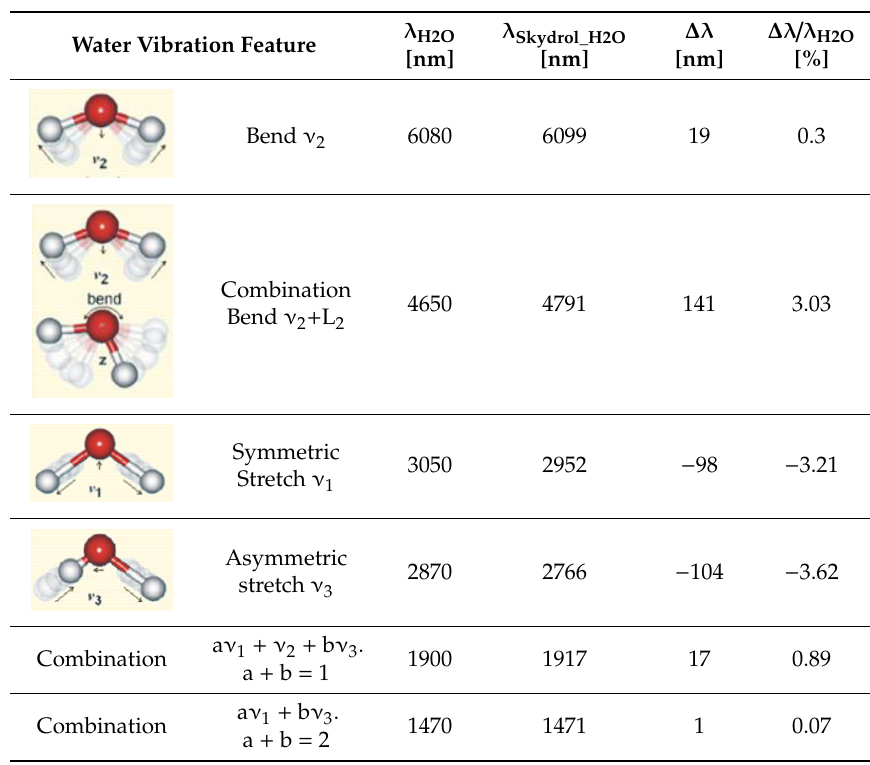
Table A2. Wavelengths of water vibrational features in Skydrol LD4 (column 2) as compared to those vibrational features that arise after water contamination and thermal degradation (column 3). Columns 4 and 5 list the respective wavelength shifts. The features noted in bold (blue) letters are assumed to derive from parent water vibrational features; the features in italic letters (red) are degradation and/or TAN specific.